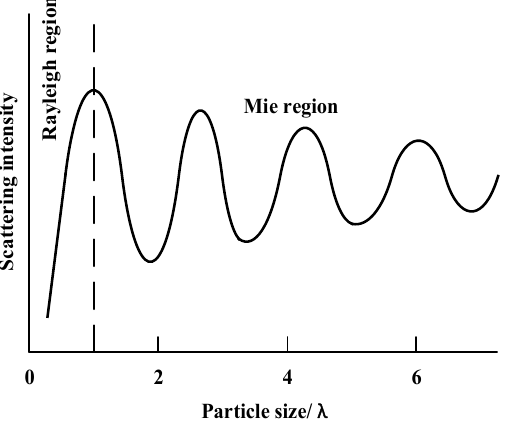
Figure 2. The relationship between particle size and scattering intensity.